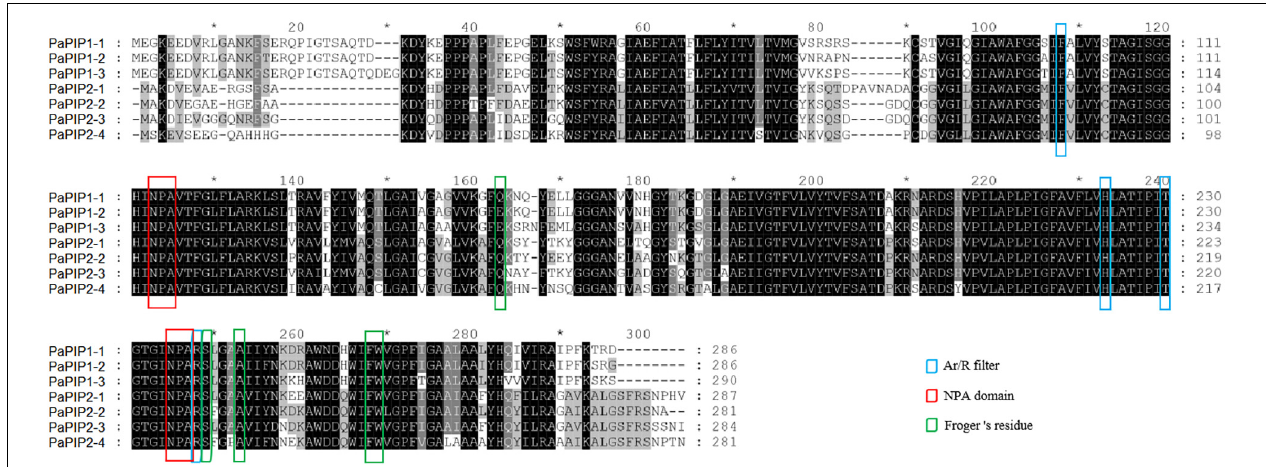
FIGURE 2 | Multiple sequence alignment of the deduced amino acid sequences of PaPIPs. Amino acids at NPA domains, ar/R selectivity filters, and Froger’s residues were identified in seven PIP family members (3 PIP1s and 4 PIP2s ) in P. armeniaca .